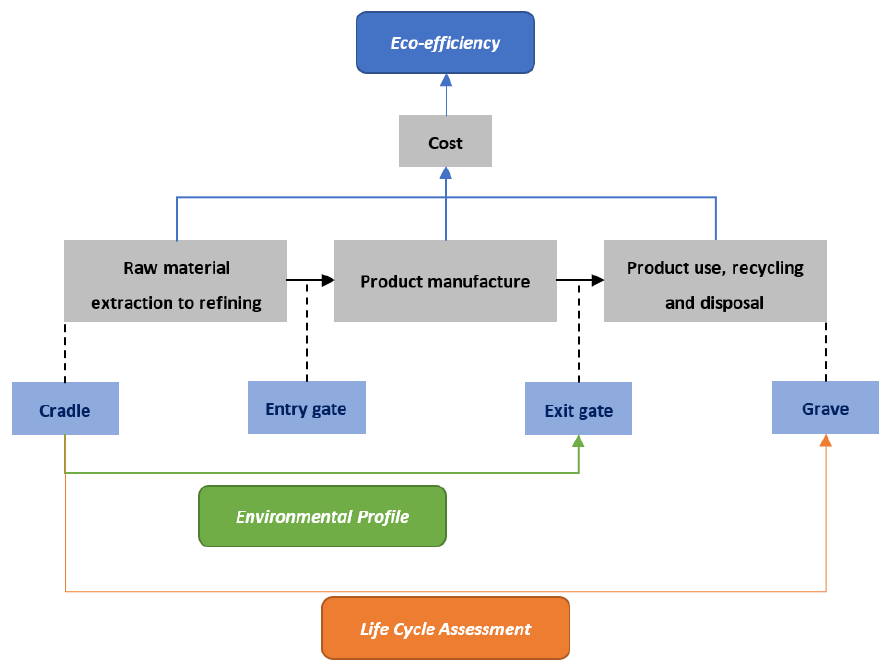
Figure 4. Eco-efficiency analysis for the mining and mineral industry [119,127].